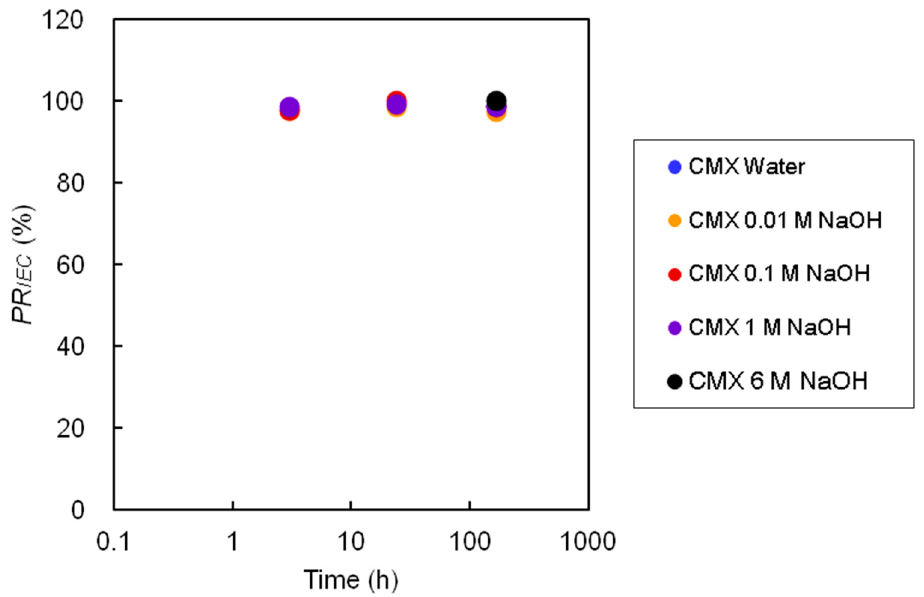
Figure A1. Normalized ion-exchange capacity (IEC) PIEC of CMX as a function of varying NaOH concentrations and immersion time periods at 40 ◦